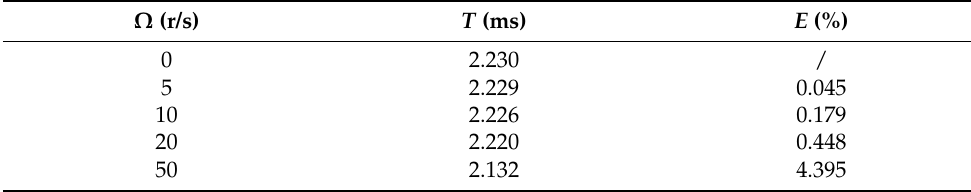
Table 2. Comparison of switching time at rotational angular velocity.